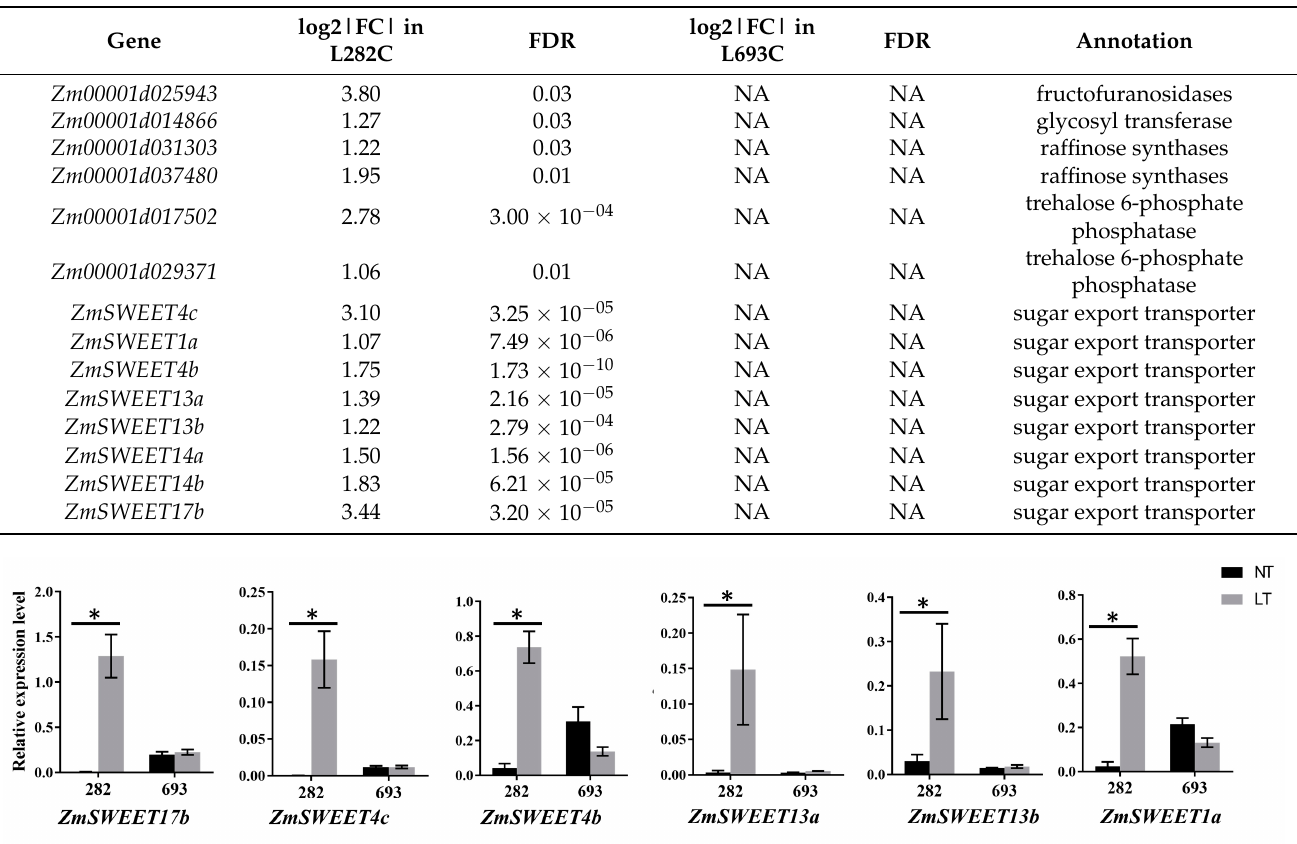
Table 2. L282 (cid:48) s specially expressed genes related to carbohydrate metabolism and transport at low temperature.